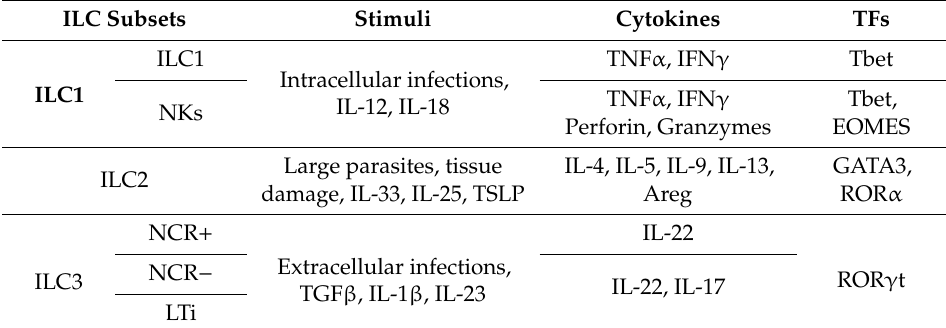
Table 1. Innate lymphoid cell (ILC) subsets. The stimuli, cytokines and transcription factors (TFs) are summarized for each